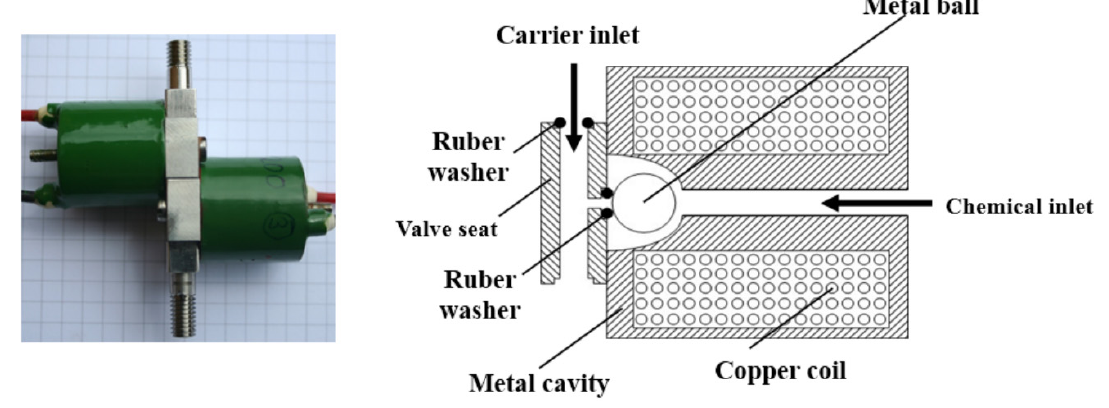
Figure 1. Structure of the RRV.